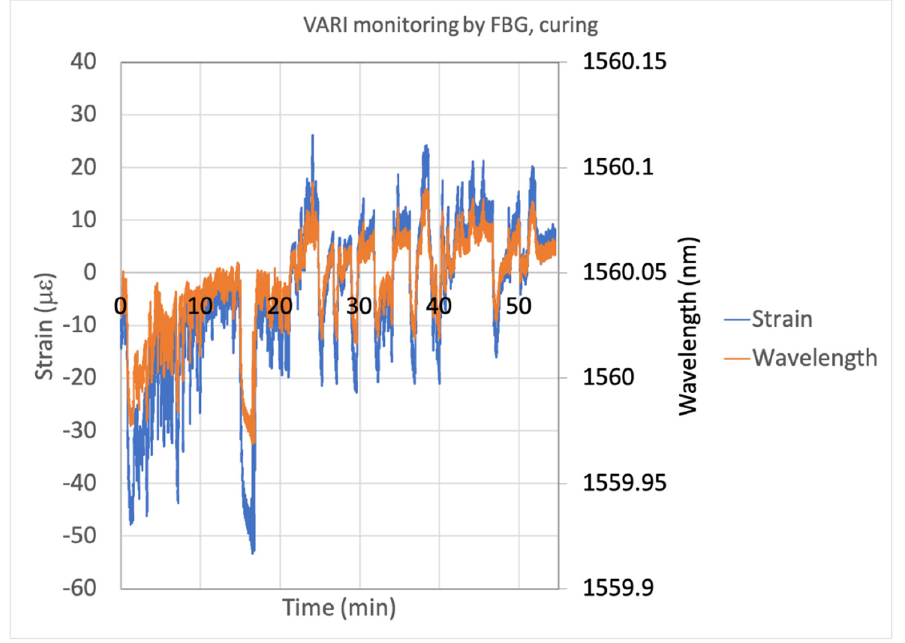
Figure 9. VARI monitoring by FBG, composite curing, identifying the first residual strains.